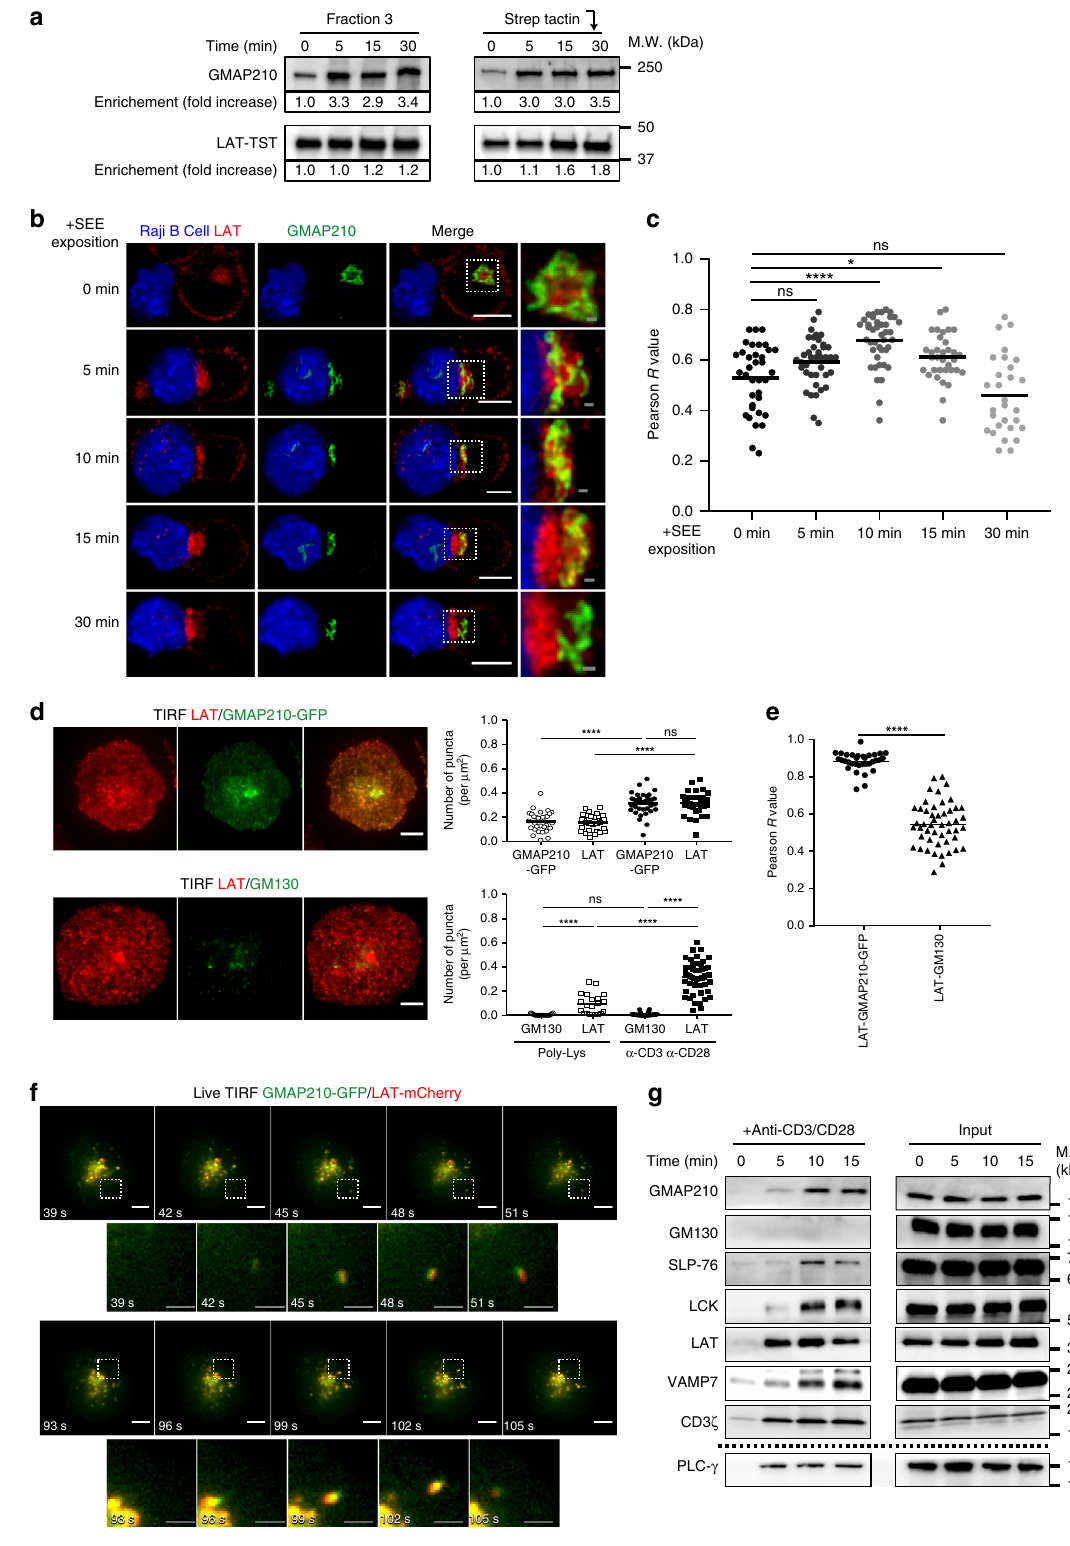
the synapse and an intertwined localization of both molecules (Fig. 2b and quanti fi ed in Fig. 2c). At 30 min GMAP210 was slightly behind the immune synapse. In these conditions, as reported by others 43,44 , we often observed the rims of the Golgi stacks, labeled with GMAP210, in close proximity to the area of the immune synapse where LAT was enriched (Fig. 2b). To